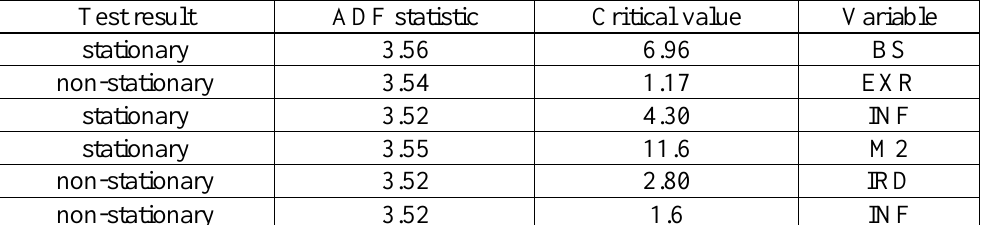
Table 1. Results of the ADF test at the data level